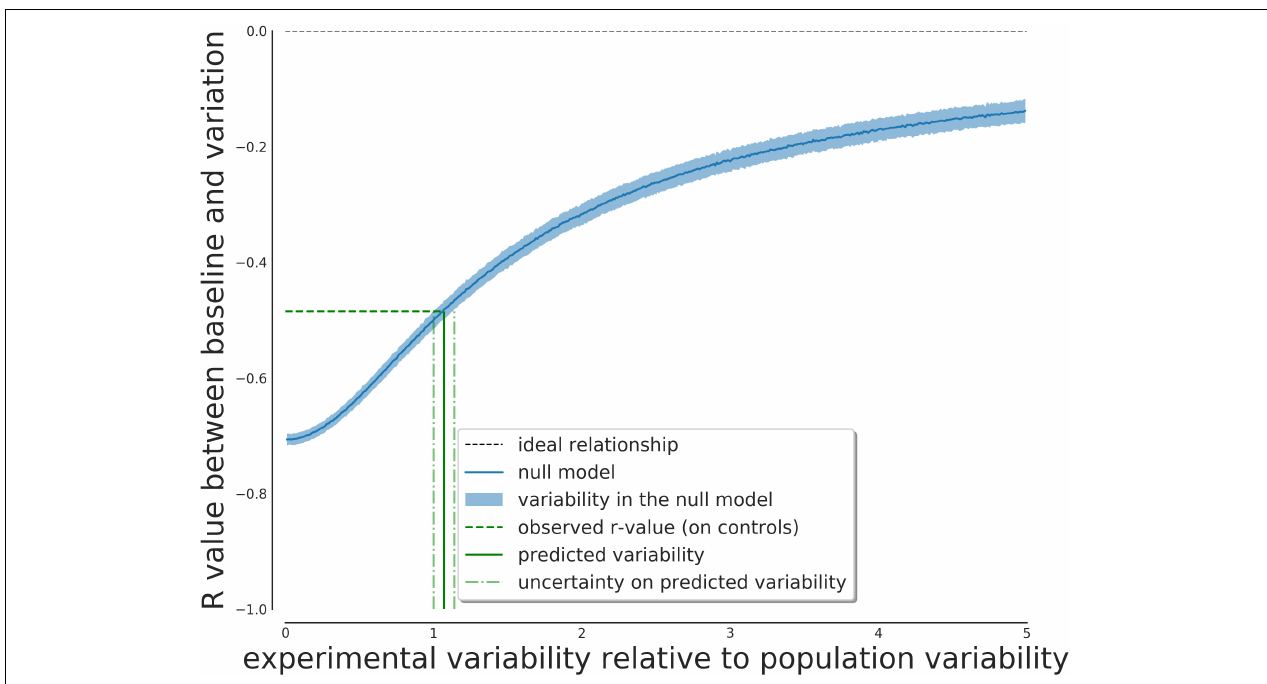
FIGURE 1 | Expected effect on the score correlation depending on the ratio between within-variability and between-variability of the subjects. This relationship can be inverted to obtain the expected ratio given the observed correlation